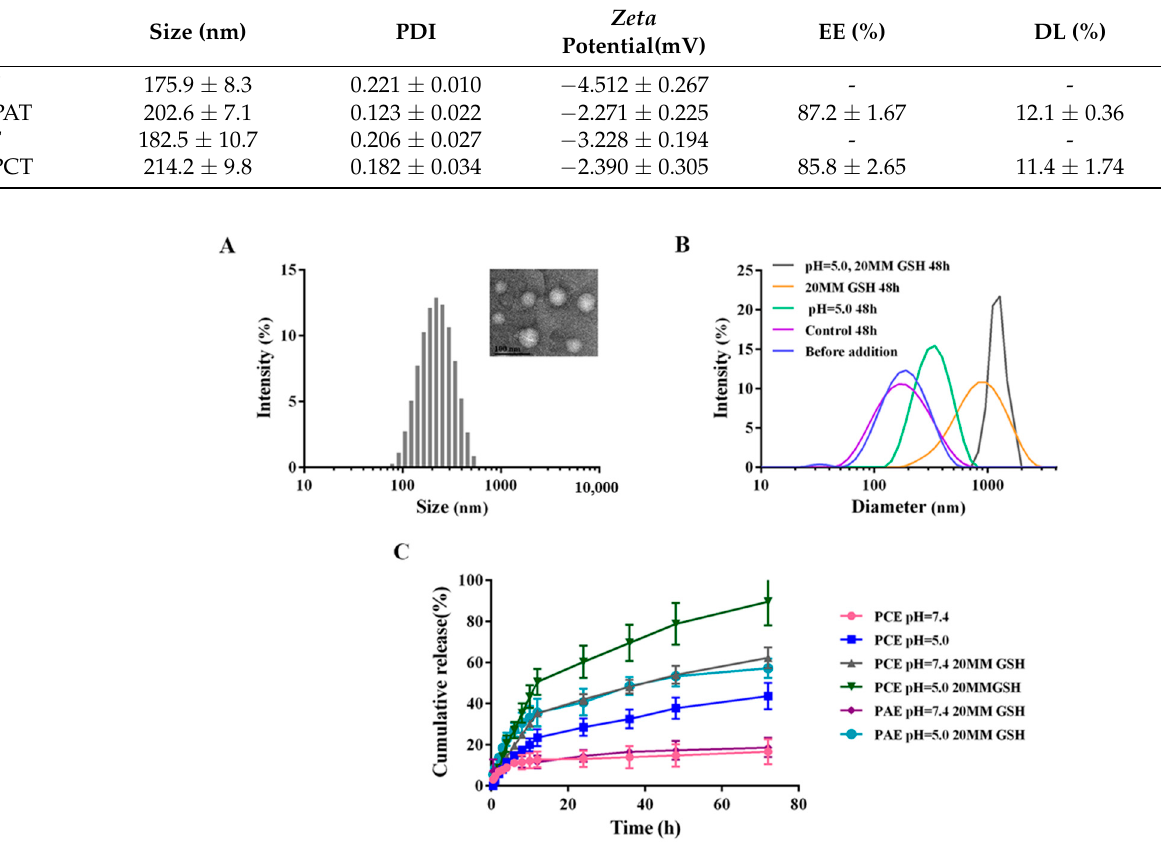
Figure 3. ( A ) The size distribution and morphology of DOX/PCT micelles. ( B ) The particle size changes and ( C ) in vitro cumulative drug release behaviors of the micelles in different pH/GSH condition. Data were expressed as mean ± SD ( n =